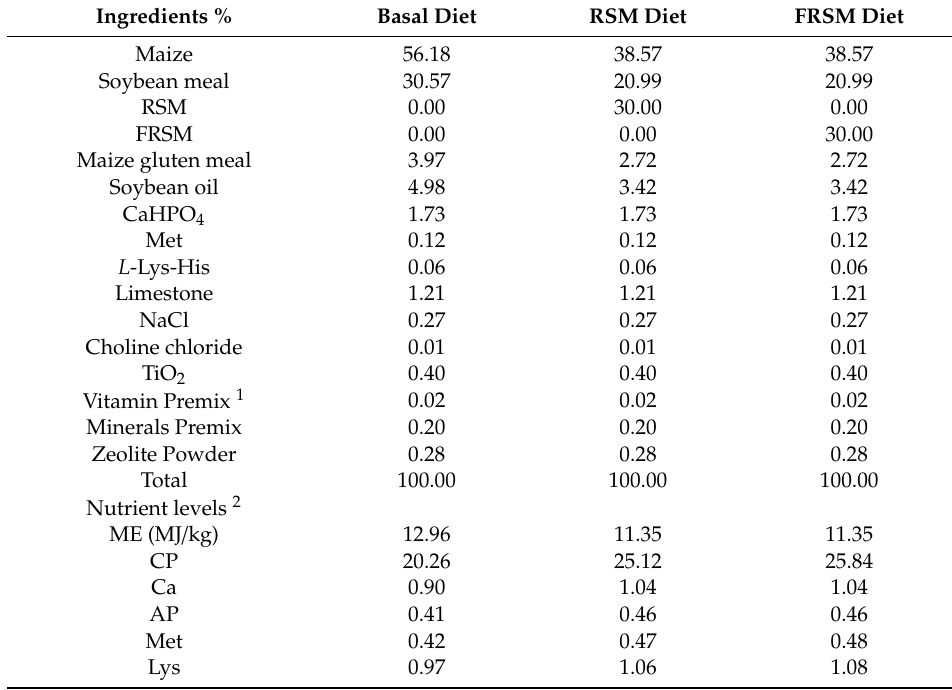
Table 2. Dietary composition and calculated analyzed nutrient levels of the test diets used for the apparent metabolizable energy (AME) and greater nitrogen-corrected apparent metabolizable energy (AMEn)